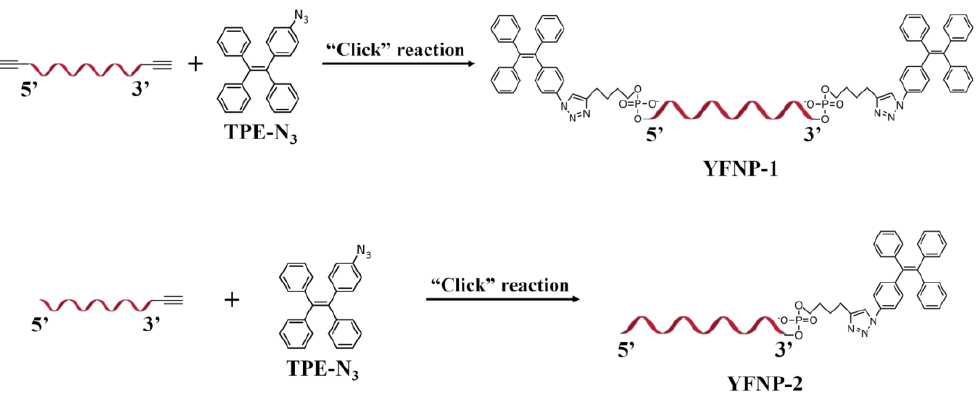
Figure 1. Synthetic route of the strands of YFNP-1 and YFNP-2.